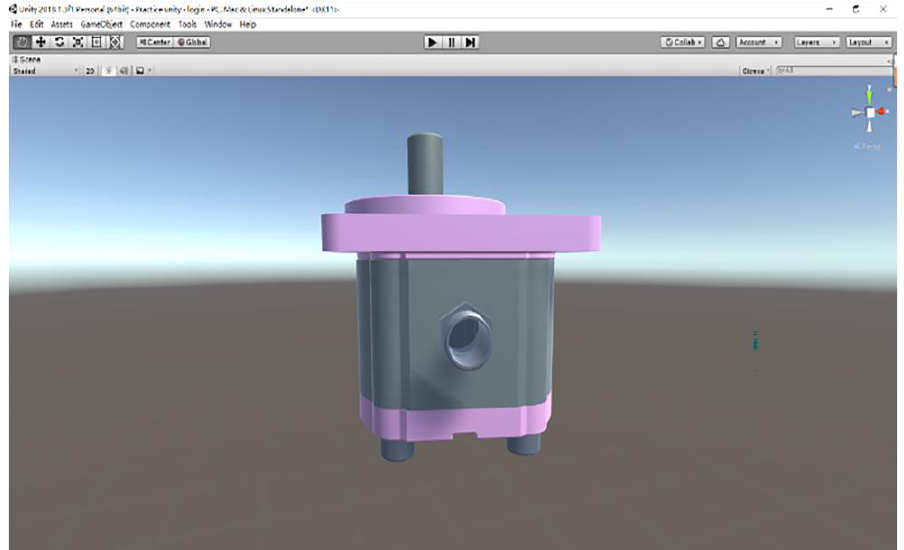
Figure 6. Three-dimensional (3D) model of an external gear pump.